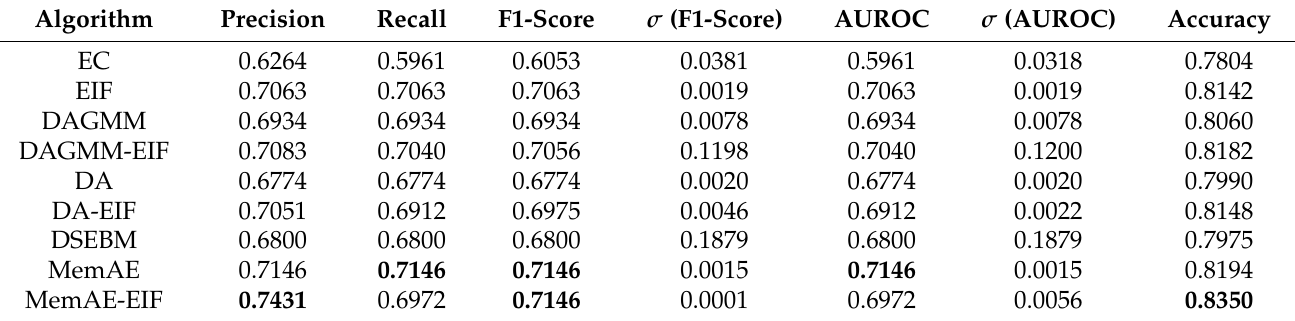
Table 5. Results obtained from testing unsupervised algorithms on the CIC-IDS2017 dataset.